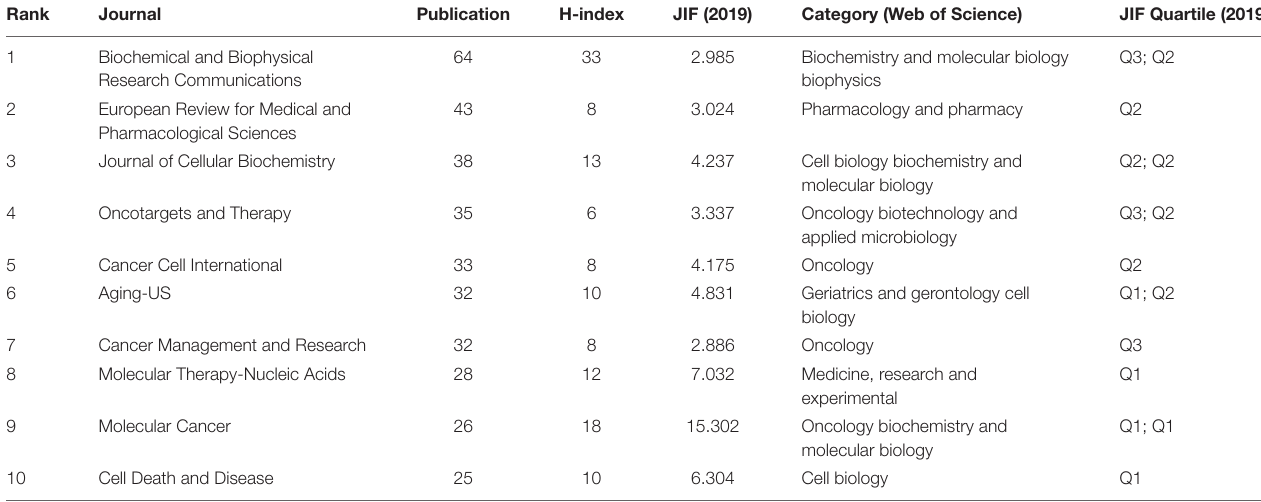
TABLE 2 | The top 10 journals ranked by number of publications.